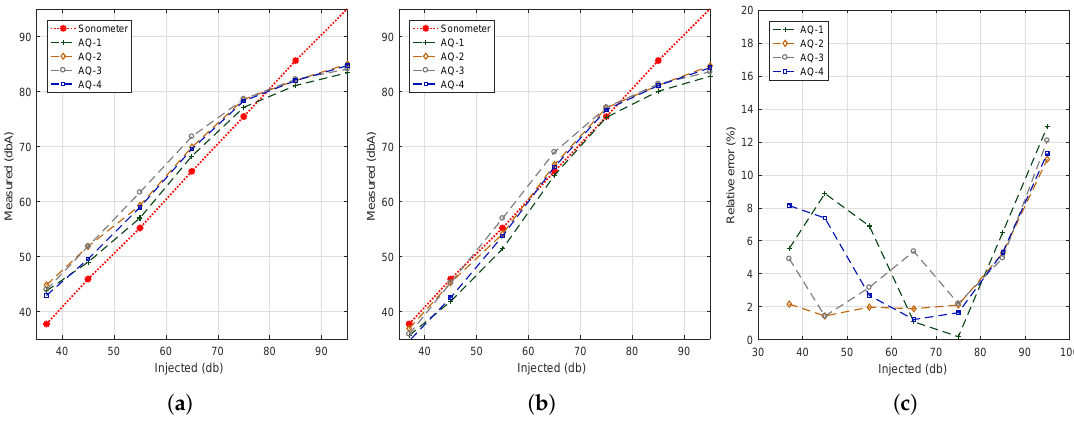
Figure 11. Estimation error analysis when using similar smartphones. ( a ) before regression; ( b ) after regression; ( c ) estimation